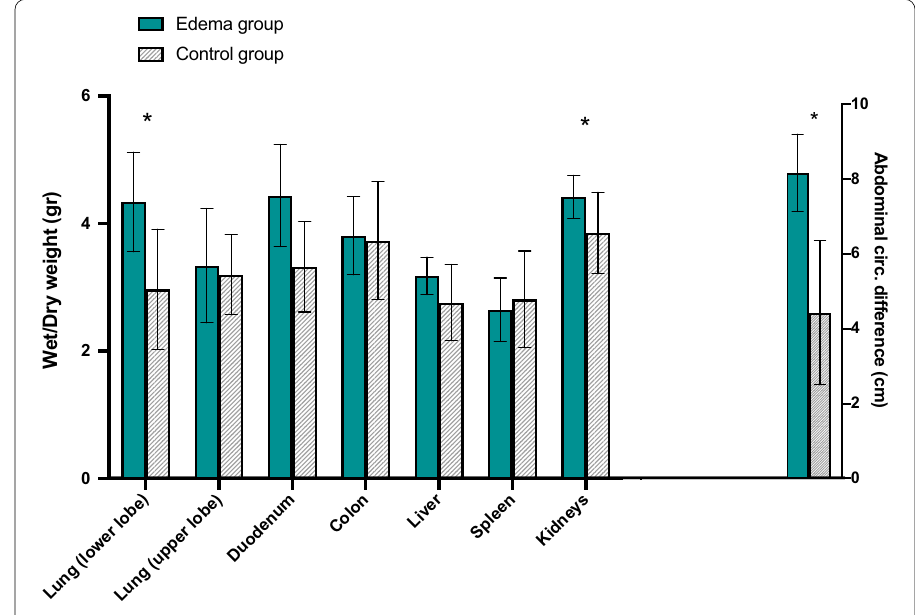
Fig. 2 Wet–dry weight and abdominal circumference